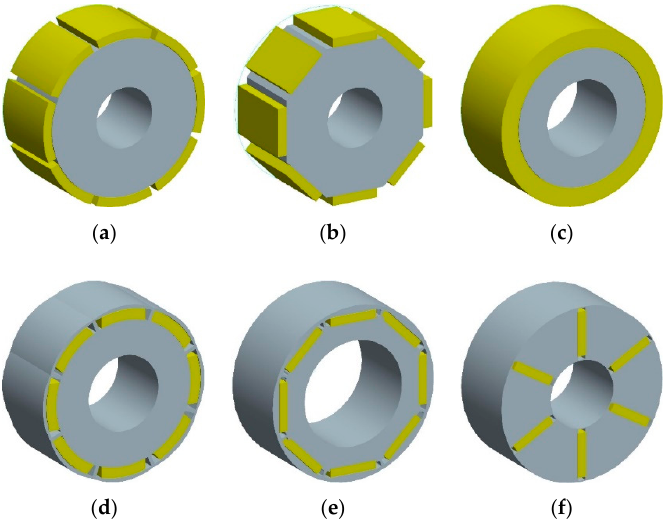
Figure 4. Overview of parametrized PM rotor topologies used in design optimization; ( a ) arc surface mounted magnets; ( b ) rectangular surface mounted magnets; ( c ) ring magnet—special case of arc surface mounted magnet; ( d ) buried arc magnets; ( e ) buried rectangular magnets; ( f ) internal magnets. Table 2. Overview of evaluated topological